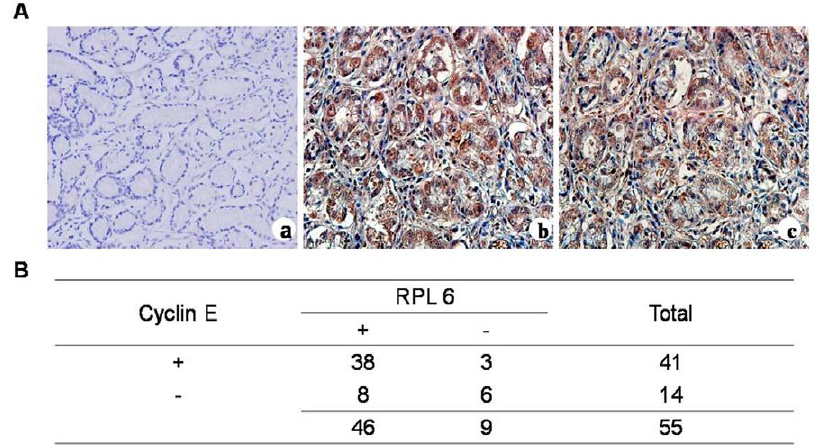
Figure 1. RPL6 and cyclinE expression in human gastric cancer specimens and matched adjacent non-neoplastic tissues. A. Representative images shown are negative immunohistochemical control of IgG (a) and positive immunohistochemical staining of RPL6 (b) and cyclin E (c) in the same gastric cancer tissues (magnification 6 200). B. Statistical analysis of data on the correlation between RPL6 and cyclinE expression in human gastric cancer specimens. (p , 0.05).